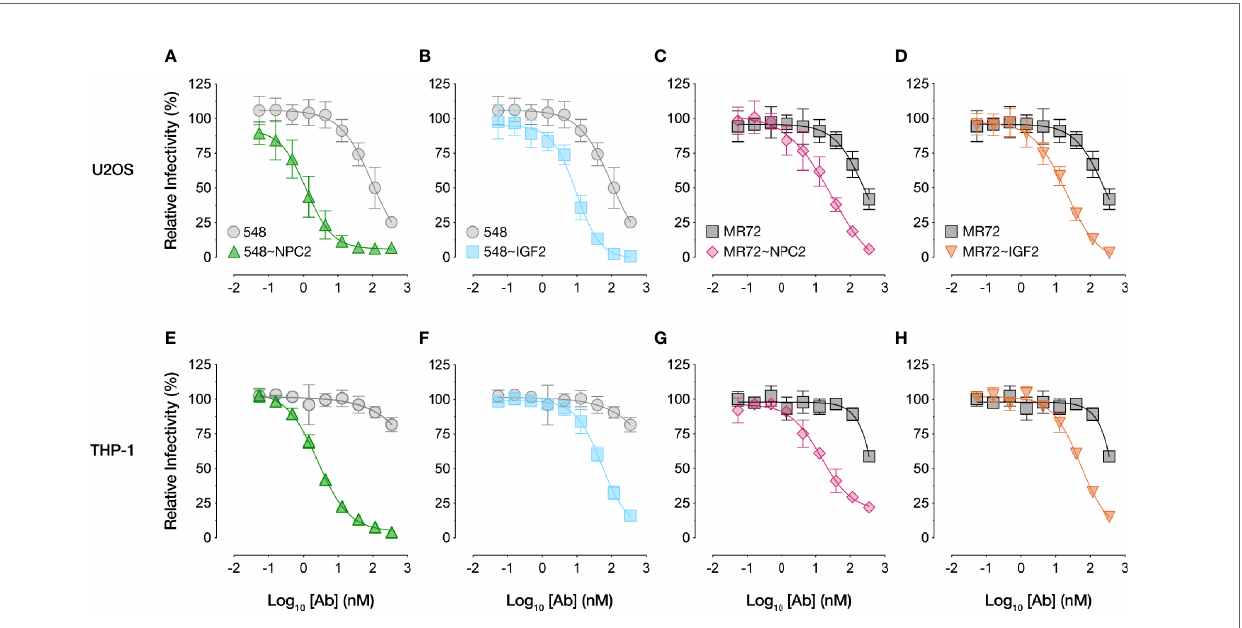
FIGURE 2 | NPC2- and IGF2-tagged bsAbs neutralize VSV-EBOV in multiple cell types. Neutralization curves of bsAbs and parental mAbs against rVSV-EBOV GP in (A-D) human U2OS osteosarcoma cells or (E-H) human THP-1 cells differentiated into macrophage-like cells. Infection was measured by automated counting of eGFP+ cells and normalized to infection in absence of antibody. Means ± SD are shown for 4 – 8 replicates from 2 – 4 independent experiments.